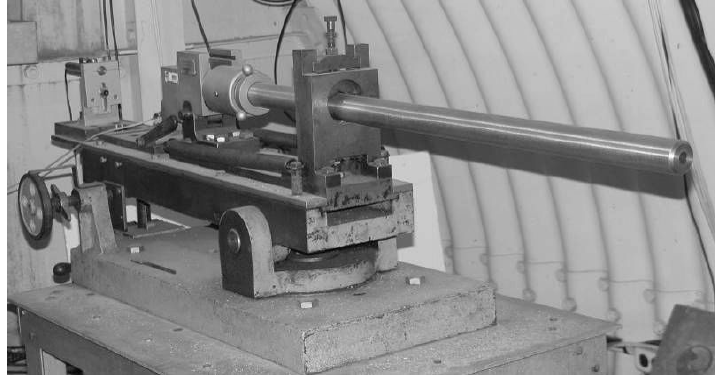
Fig. 3. Modern bond universal small-arms receiver used to fire the projectiles.